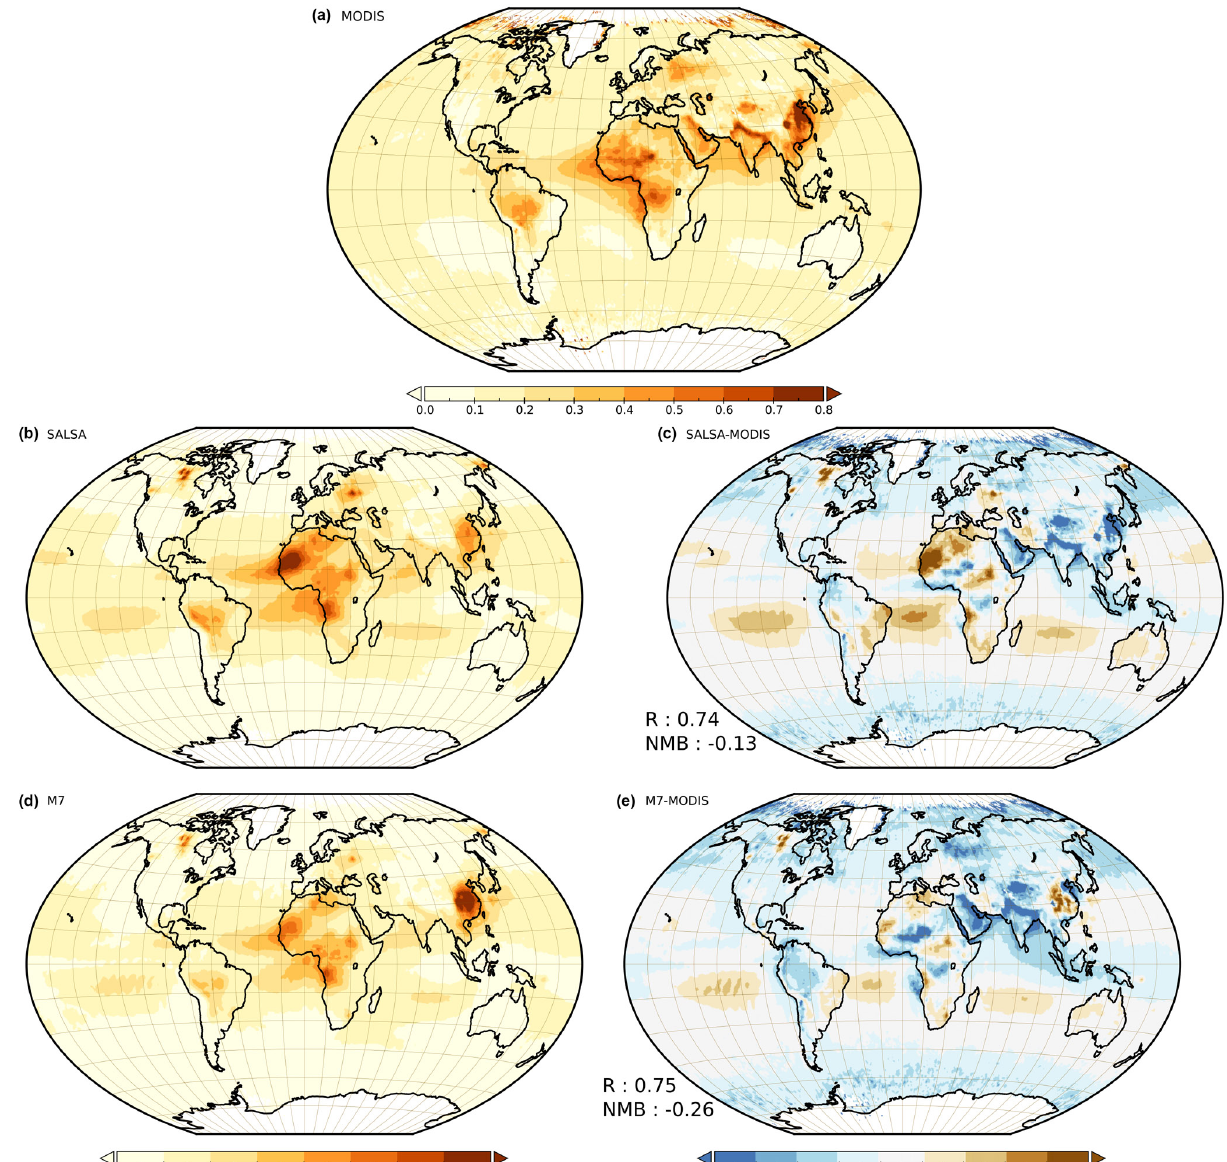
Figure 2. Yearly mean aerosol optical depth (AOD) for the year 2010 retrieved by (a) MODIS (Aqua and Terra combined), and modeled by (b) SALSA2.0 (model data collocated with Aqua and Terra retrievals), and (c) M7 (model data collocated with Aqua and Terra retrievals). Absolute differences between (d) MODIS and SALSA2.0, (e) MODIS and